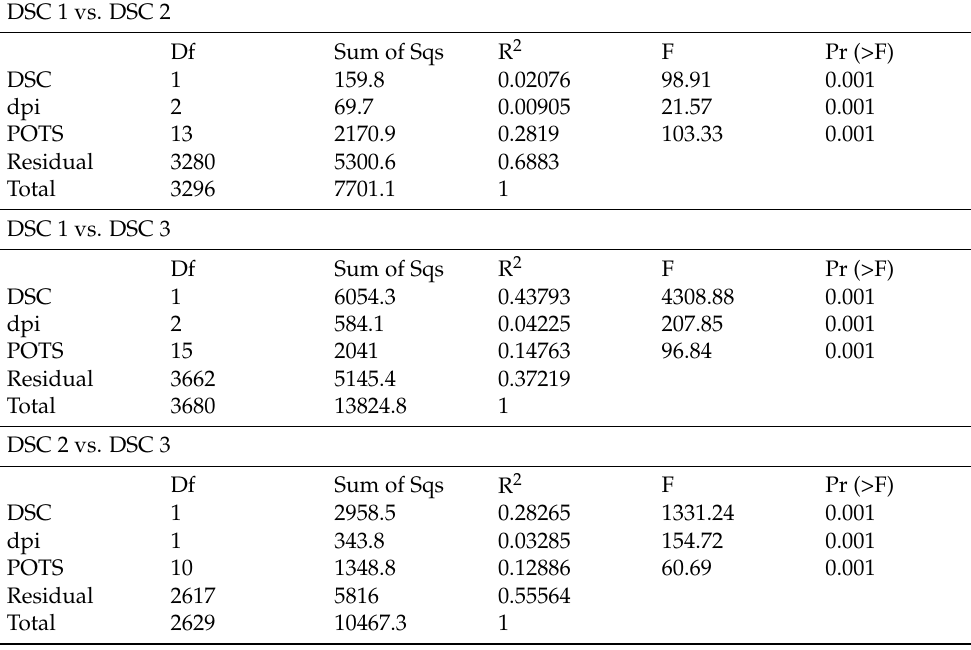
Table 1. Results of pairwise Permutational MANOVA applied only to infected plants. DSC: Disease severity classes; dpi: Days post infection; and POTS: Pots identification number.